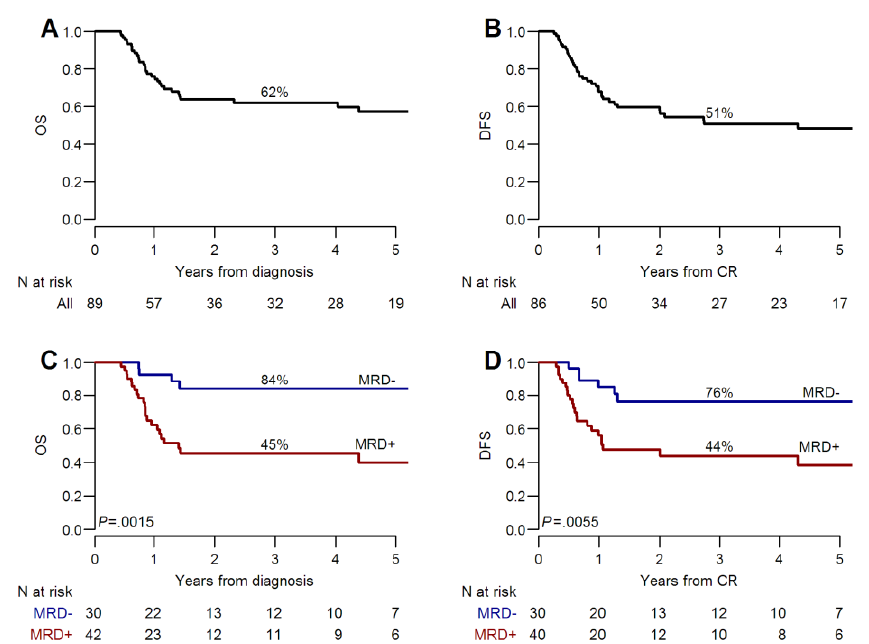
Figure 1. Overall survival and disease-free survival for the whole cohort ( A , B ) and according to MRD status ( C , D ).